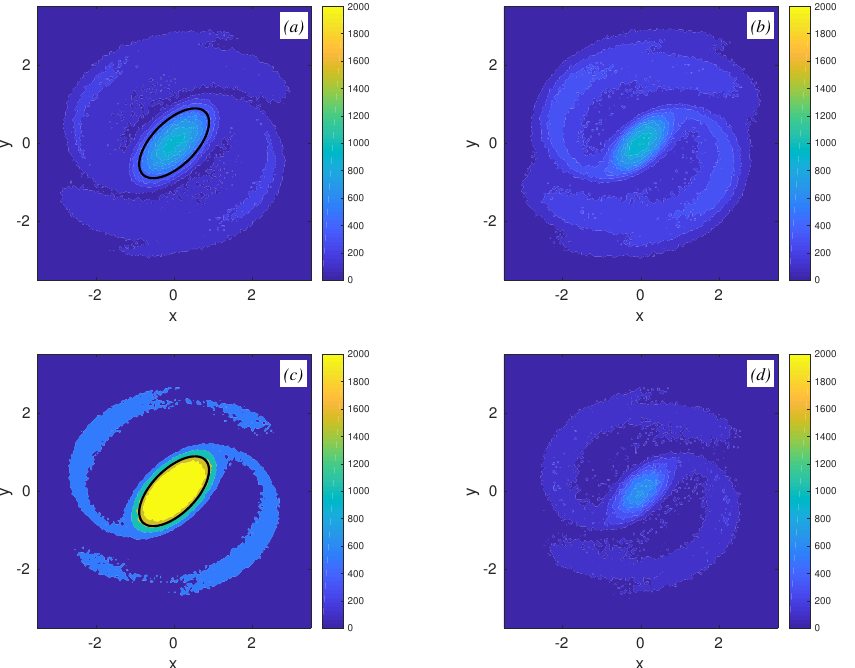
Figure 33. ( a – d ) Same as in Figure 32 for the case of a non-stationary vortex ( (cid:101) ( 0 ) = 2 and ϕ ( 0 ) = π i.e., the markers are mixed due to both deterministic stirring and stochastic